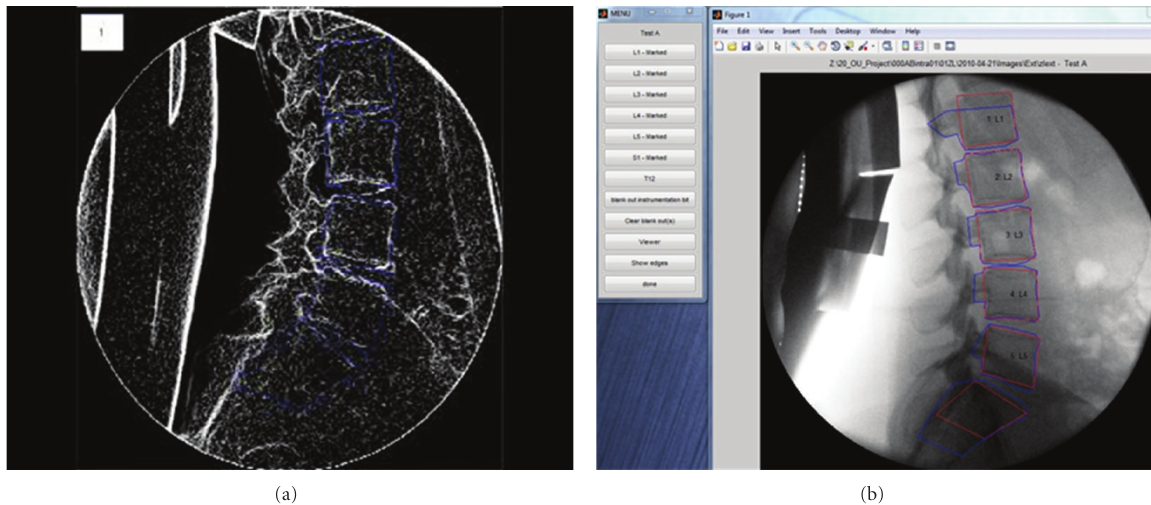
Figure 4: (a) Lateral view of lumbar spine image with enhancement. (b) User interface output showing lateral view of lumbar spine image with tracking and reference